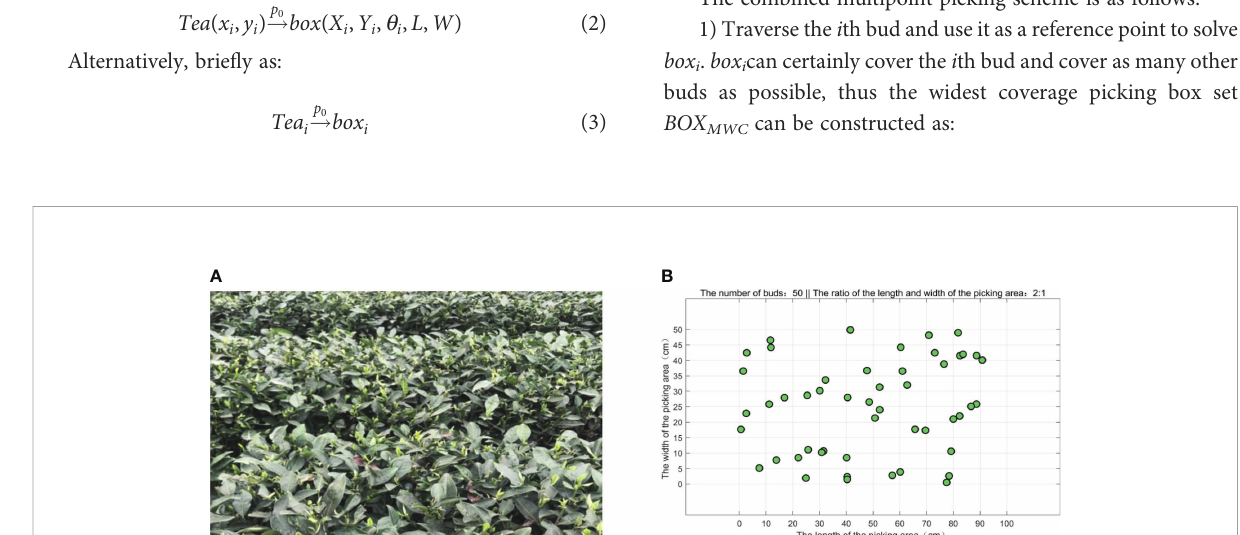
FIGURE 3 The distribution of the tea buds in a picking area. (A) The actual distribution of the buds in the fi eld. (B) The simulated distribution of 50 buds in a picking